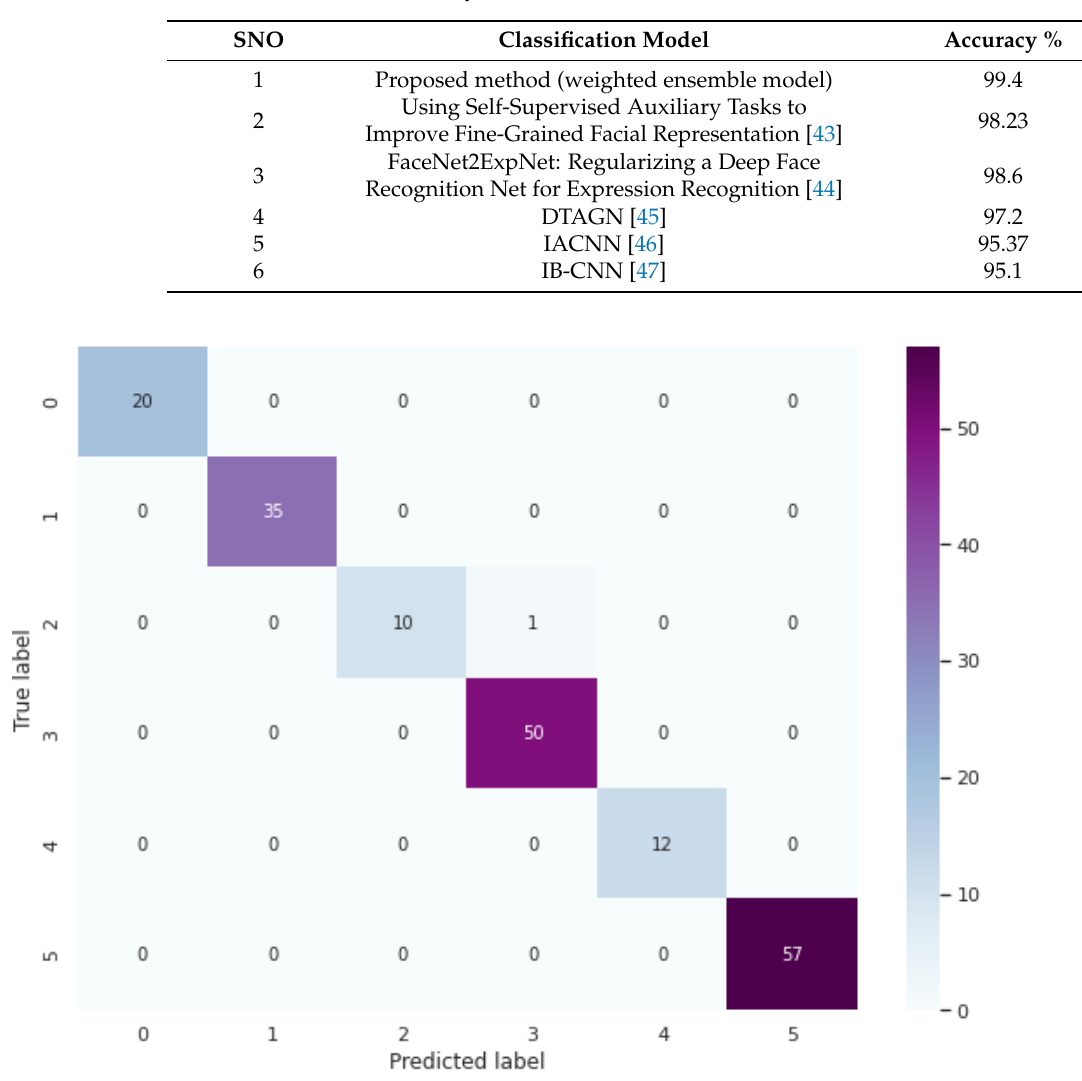
Table 2. Classification accuracy on the CK+ dataset.